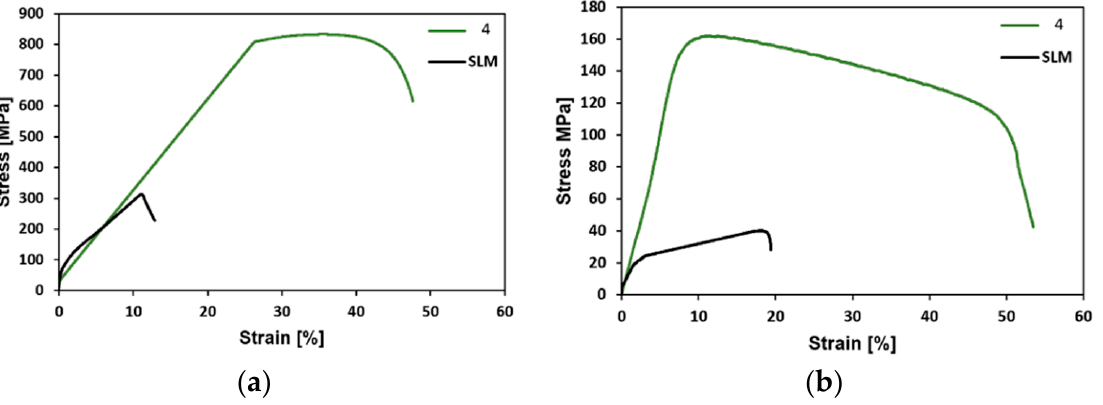
Figure 7. Tensile test stress-strain curves for the SLM workpiece and the 4 swaged piece acquired at: room temperature ( a ); 900 °C ( b ).